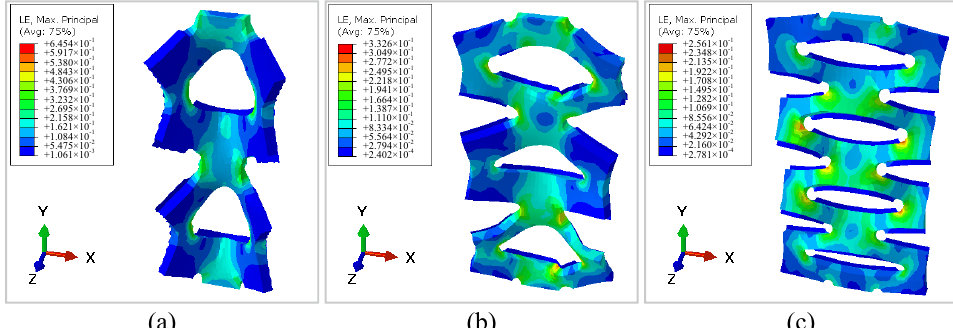
Figure 9. Finite element analysis (FEA) results of kirigami-inspired flexible sponge sensors with ( a ) a two-unit kirigami cutting pattern, ( b ) a three-unit kirigami cutting pattern and ( c ) a four-unit kirigami cutting